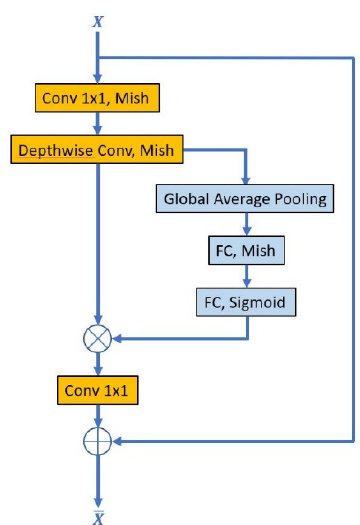
Figure 16. Semantic segmentation model.